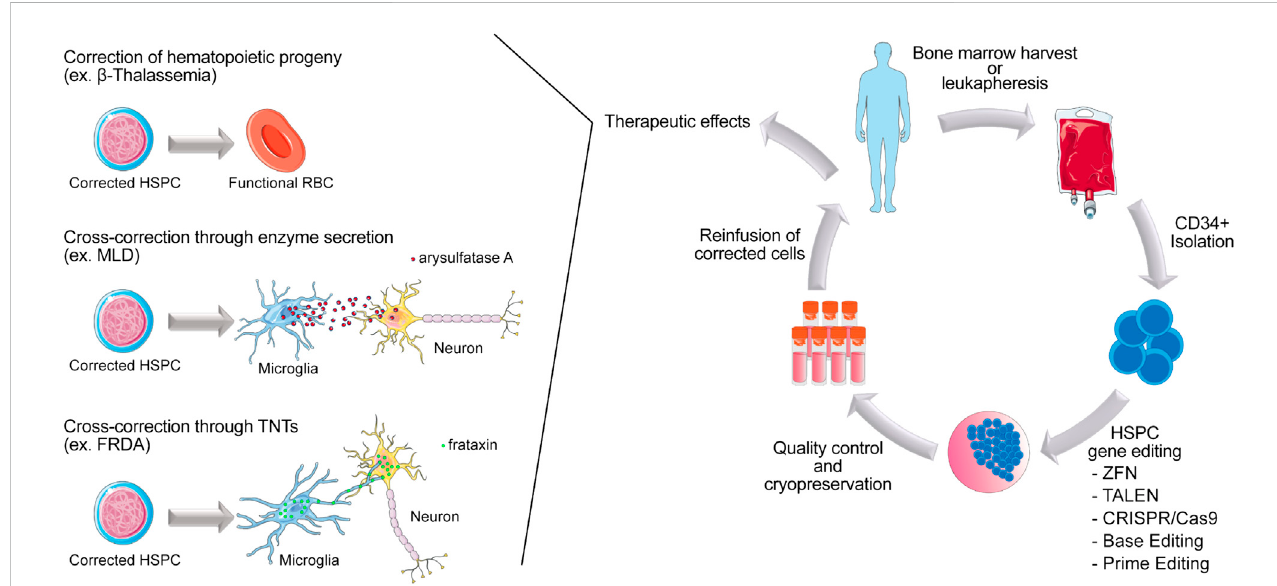
FIGURE 1 Scheme of autologous HSPC gene editing in patients affected by inherited genetic disorders. HSPCs are collected from the patient from the bone marrow or peripheral blood. CD34 + are isolated and gene modi fi ed ex vivo , using gene editing tools. After a short period of culture, cells are cryopreserved before being reinfused in patients. Once engrafted, corrected HSPCs can give rise to functional blood and immune cells in the context of blood related disorders such as Beta-thalassemia. Corrected HSPCs can also cross the blood brain barrier and differentiate into microglia to perform tissue cross correction by either enzyme secretion (ex. MLD) or protein transfer via TNTs (ex.